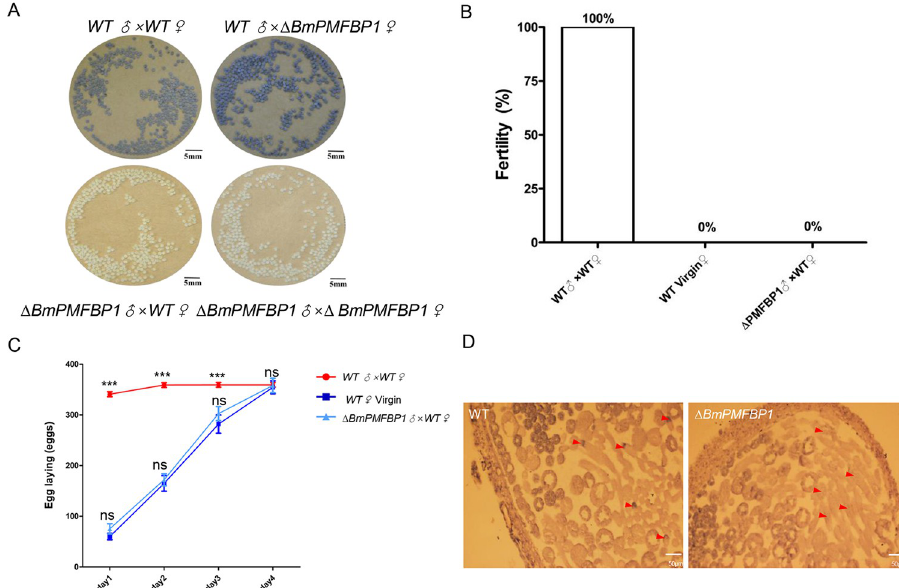
Fig 3. BmPMFBP1 deficiency results male sterility. (A) Photograph of eggs after 8 days laid by wildtype or mutant females mated with wildtype or mutant males. The color of eggs indicated whether the egg is fertilized. Pale yellow eggs are unfertilized, dark black eggs are successfully fertilized. (B) Fertility of BmPMFBP1 male mutants. Fertility was evaluated as the ratio of fertile individuals to the total number of individuals (n = 20). (C) The cumulative amounts of eggs laid by female. Data are mean ± SEM (n = 30, ns indicates no significant difference compared with WT Virgin, P > 0.05; ��� indicates significant difference compared with the WT Virgin, P < 0.001)). (D) Morphologies of internal structure of wildtype (left) and BmPMFBP1 mutant (right) testis. The red triangles indicate the nuclei of eupyrene sperm bundles.